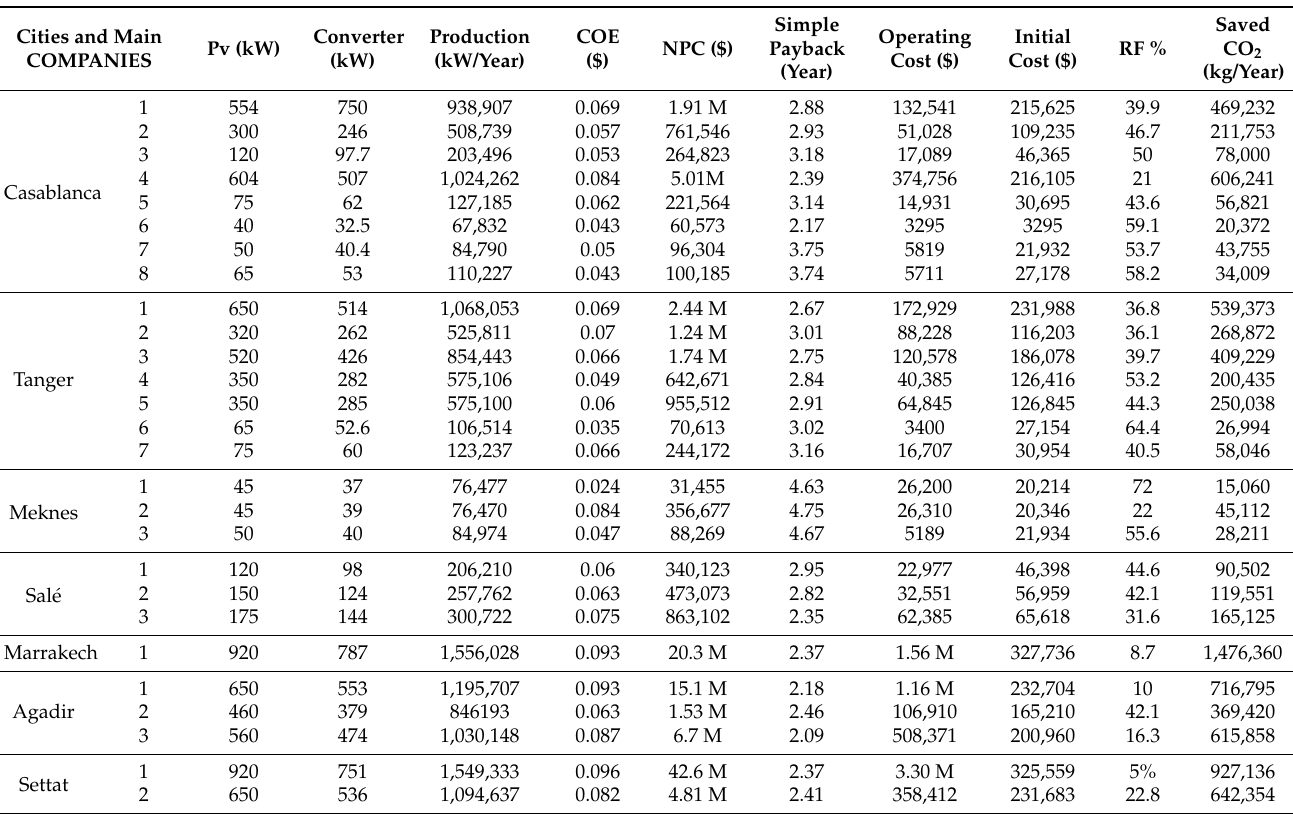
Table 6. Summary results for different